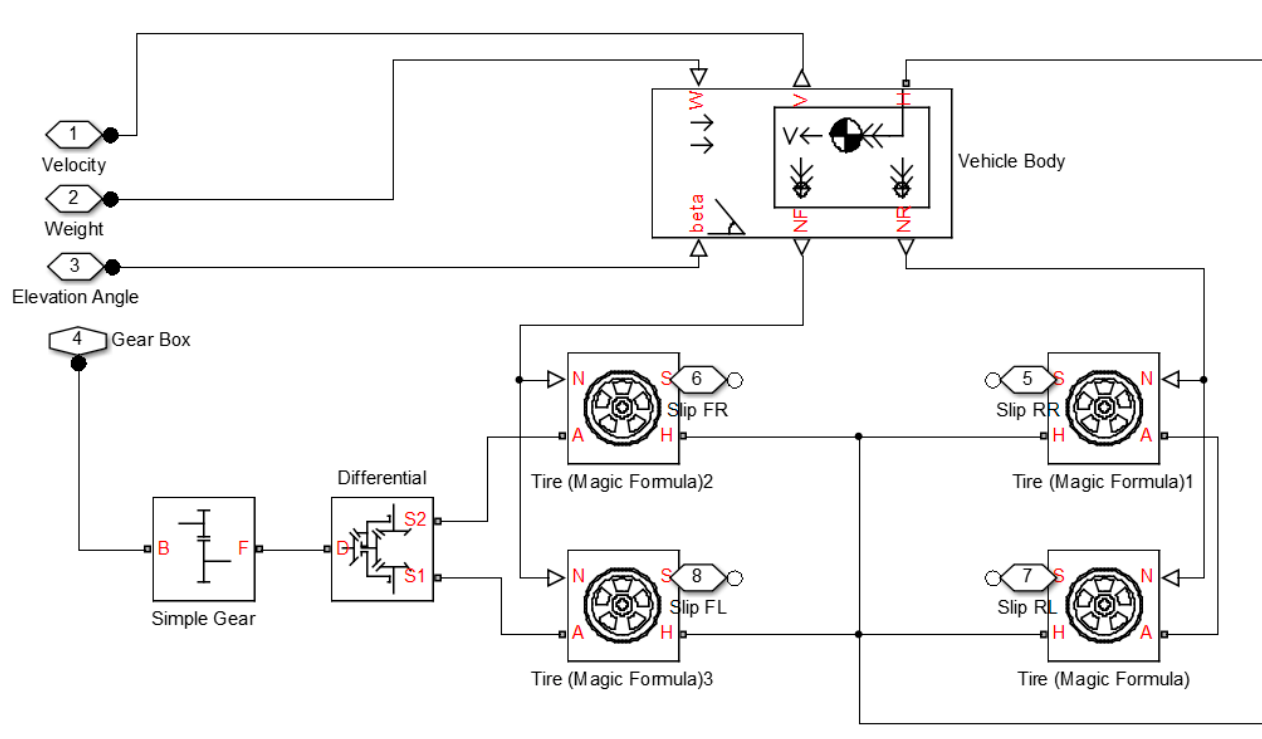
Figure 3. The Ayla’s vehicle body for testing.